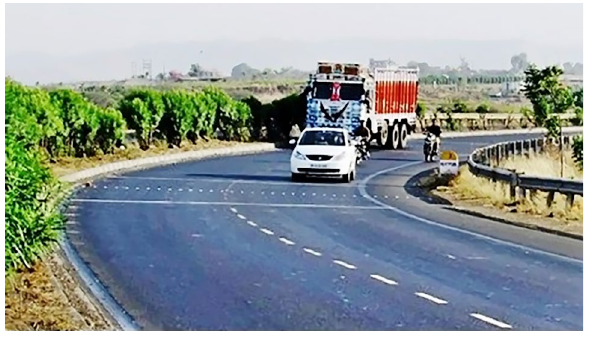
Figure 1. Typical image of the